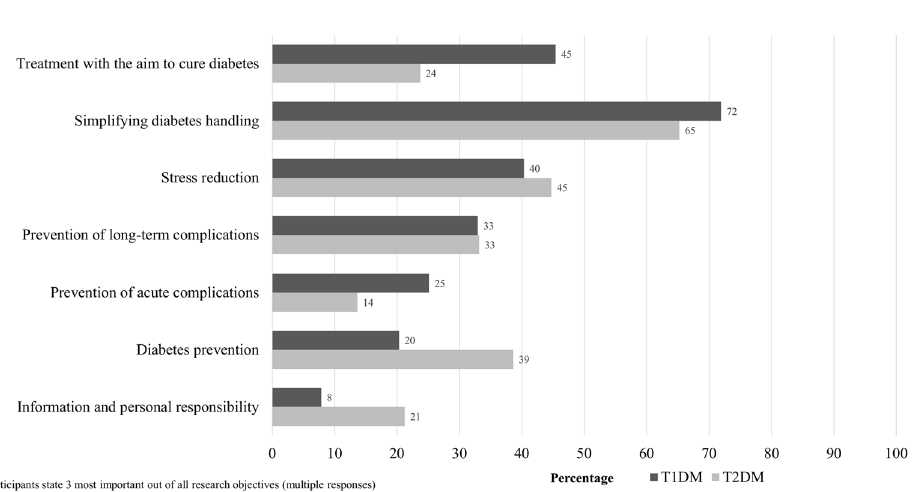
Figure 3. Priorities of people with T1DM (n = 295) and T2DM (n = 523) regarding categories of future diabetes- related research